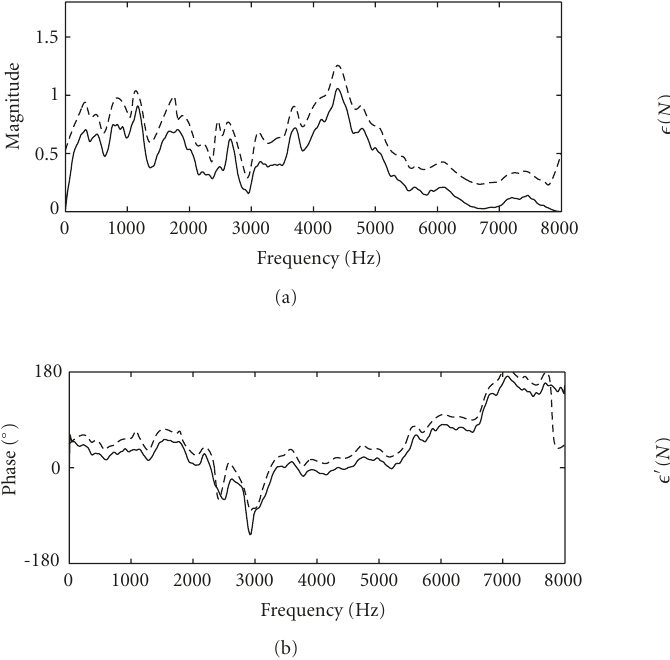
Figure 11: (cid:2) ( N ) and (cid:2) (cid:2) ( N ) for all eleven ATFs of case (C-3).